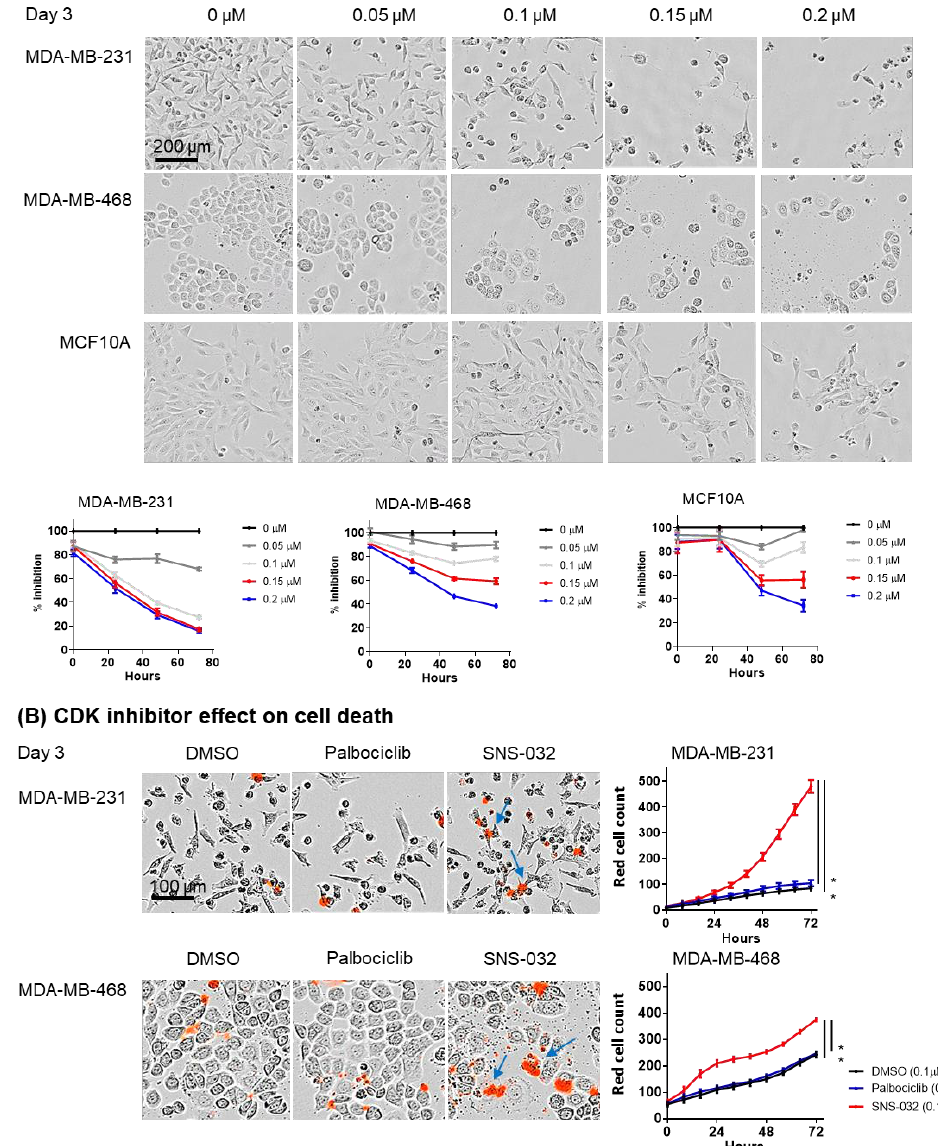
Figure 3. SNS-032 effect on cell growth and cell death by IncuCyte Zoom Live-Imaging analysis. ( A ) live phase-contrast images were taken using the IncuCyte Zoom Live-Imaging system to determine the effect of SNS-032 (0.1 and 0.2 µ M) on cell growth over a 72 h period ( n = 3). Scale bar of representative images = 200 µ m. ( B ) Red fluorescence dead cell marker ethidium homodimer-1 was added to inhibitor- treated cells to determine the effect of SNS-032 or palbociclib (0.1 µ M) on cell death over a 72 h period ( n = 3). Scale bar of representative images = 100 µ m. Significant restrictions in cellular growth and increases in cell death were shown in TNBC cell lines with SNS-032 treatment. All p -values were reported with the following associated symbols: p < 0.05 (*), and all tests were two-sided.